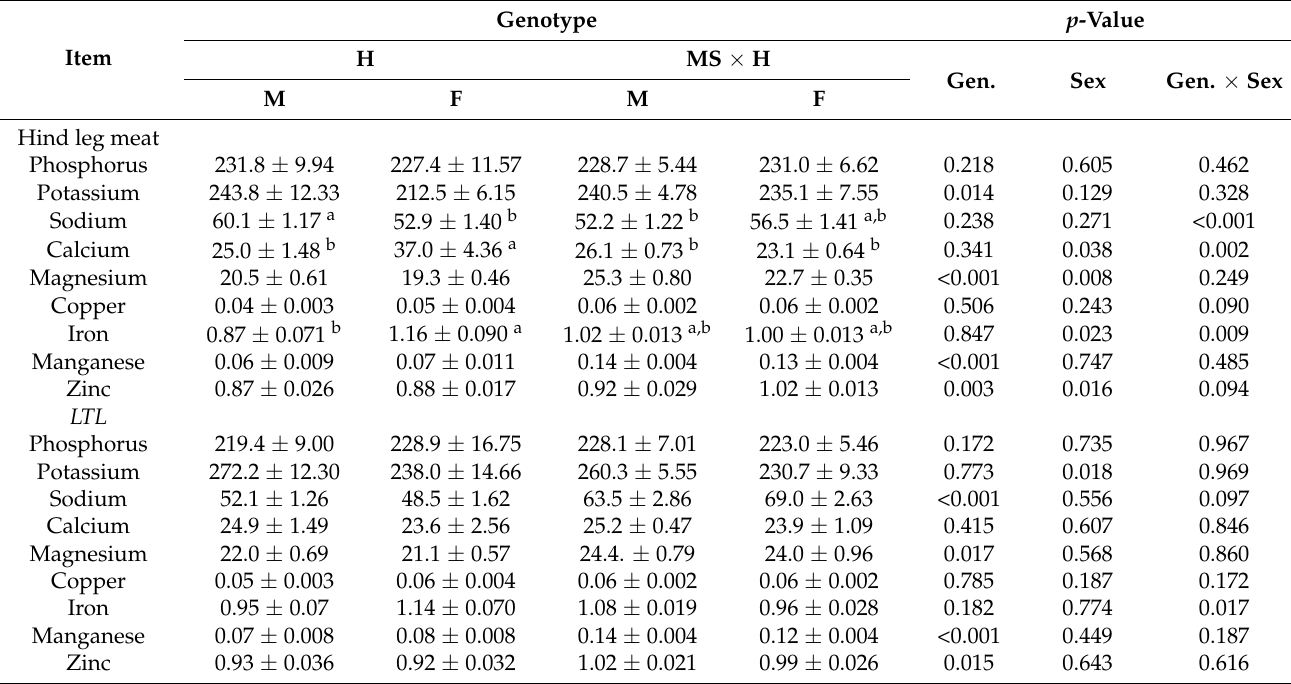
Table 5. Content of mineral elements (mg/100 g of fresh meat) of rabbit meats in relation to the genotype and